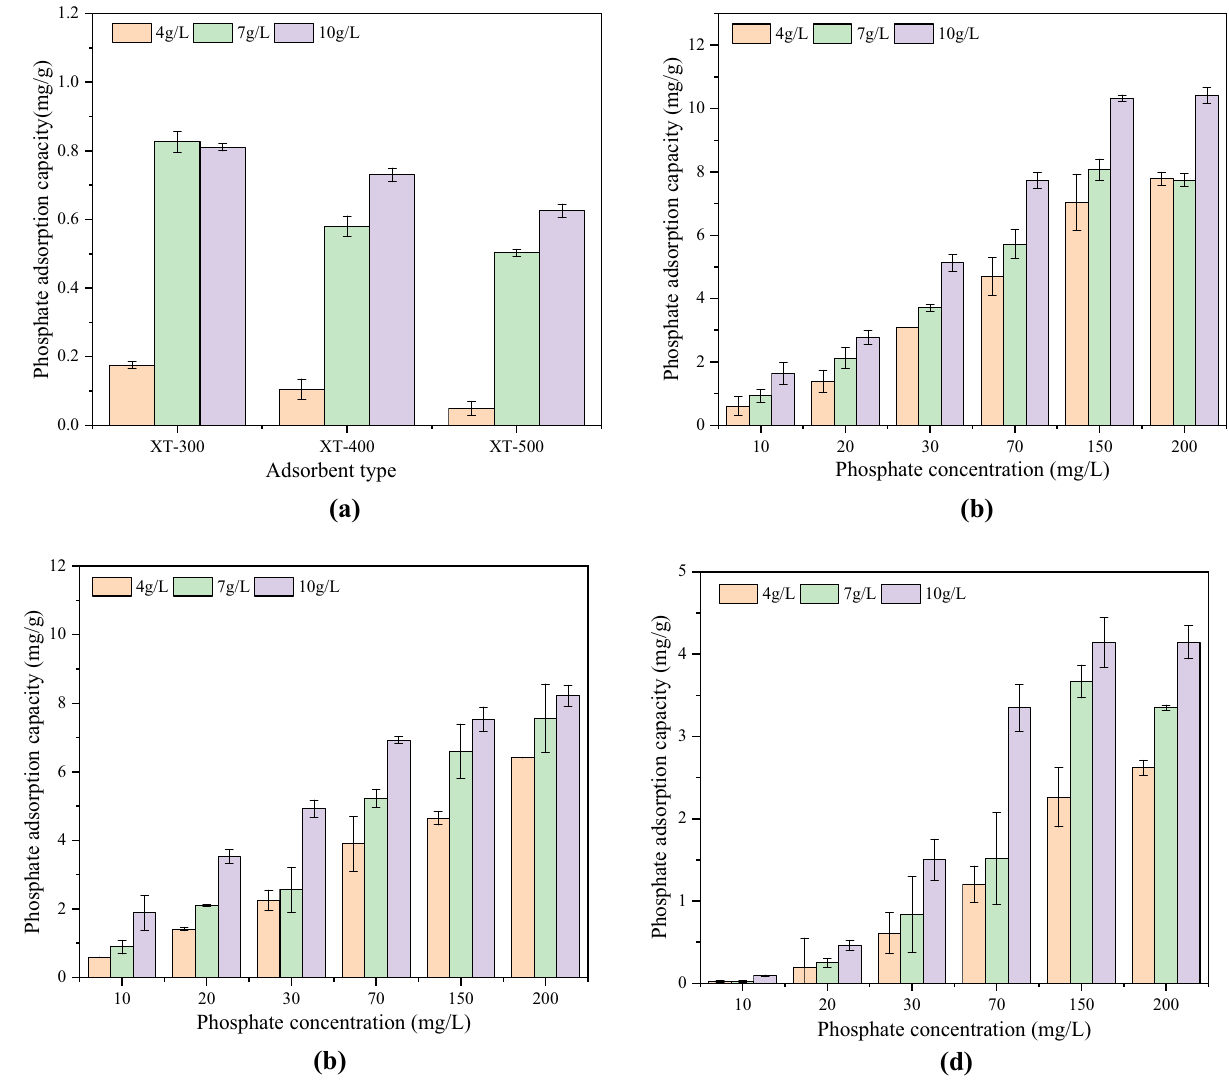
Figure 2. Phosphate adsorption capacity of pyrolytic adsorbents at different temperatures for actual Phosphorus-containing wastewater ( a ) and simulated phosphorus-containing wastewater ( b ) XT-300, ( c ) XT-400, ( d )